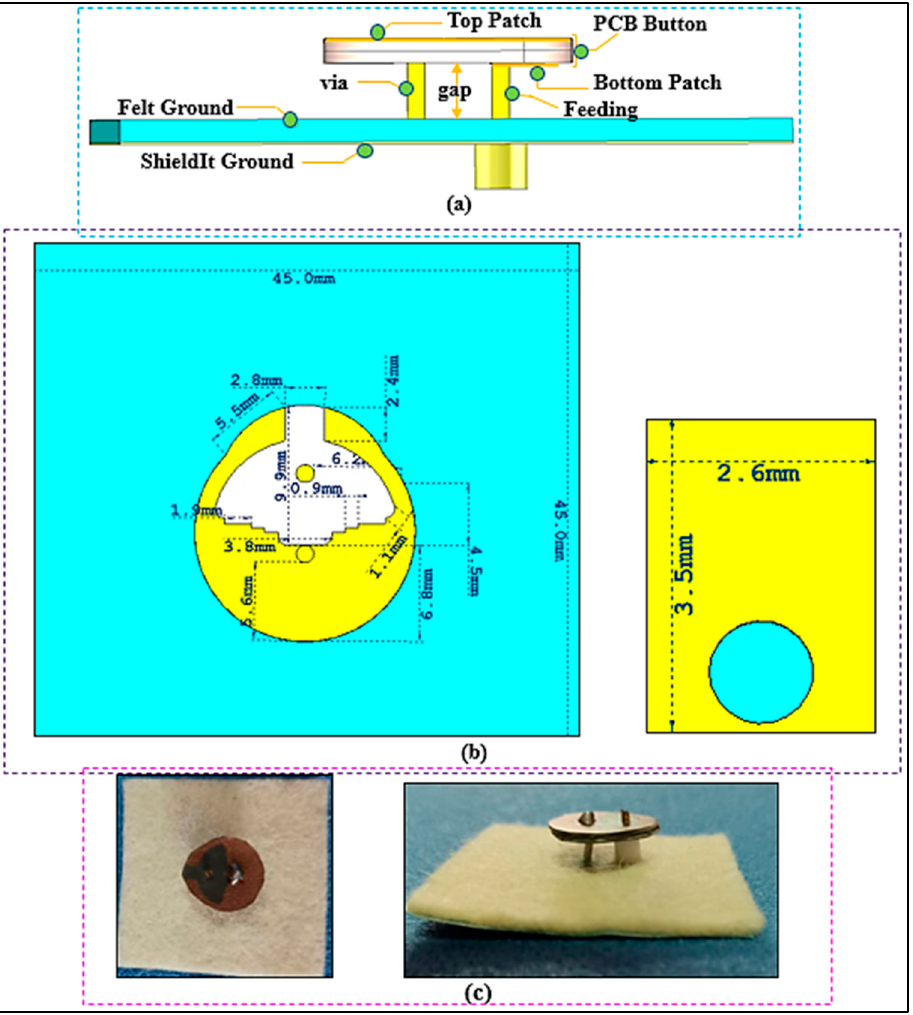
Figure 3. Structure and dimensions of the BSA (dimensions in the given mm): ( a ) the side view; ( b ) the top view; and ( c ) the fabricated BSA.